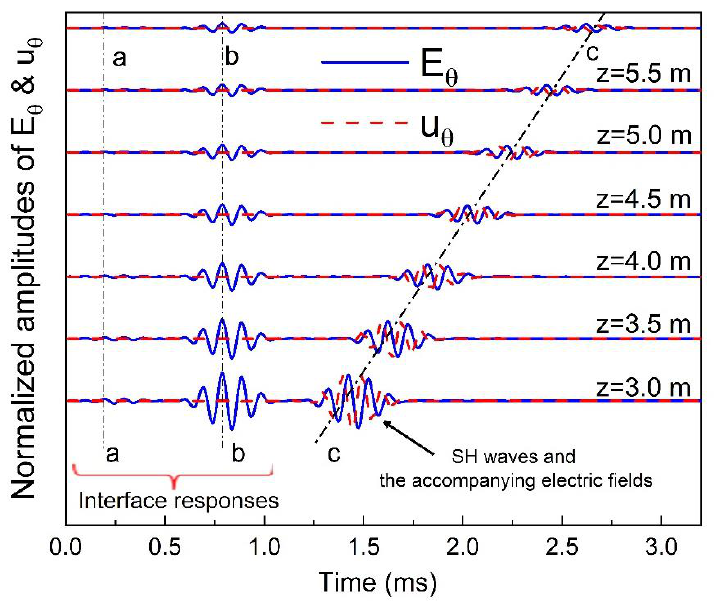
Figure 7. Borehole SH-TE acousto-electric fields when the formation has a salinity difference across an interface. The solid line is 𝐸 𝜃 , and the dashed line is 𝑢 𝜃 . The components a-a and b-b are the electromagnetic wave interface responses generated at borehole wall and salinity difference interface respectively, and the component c-c is accompanying electric